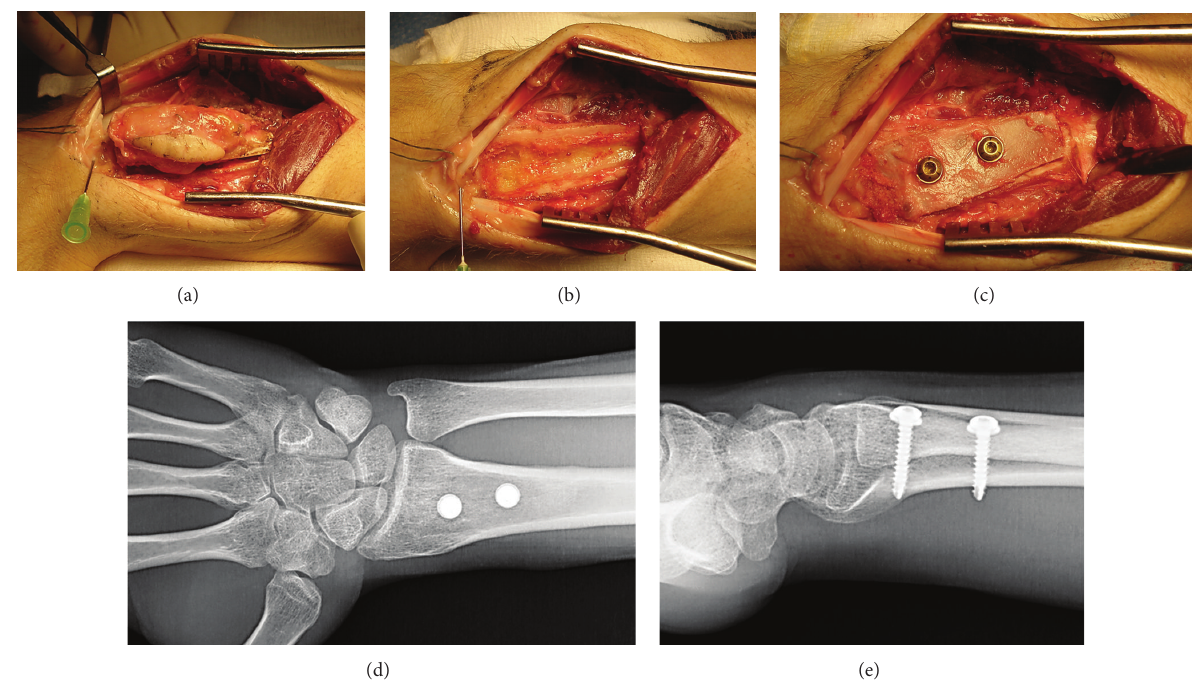
Figure 3: ((a)–(c)) Intraoperative images. (a) En bloc resection of the biopsied area, soft tissue neoplasm, and osseous lesion. (b) Transverse semicircular osteotomy and curettage of the distal radial metaphysis. (c) Iliac crest allograft stabilized with two 3.5 mm. screws. ((d)-(e)) AP and lateral radiographs of the wrist three years after operation showing complete graft